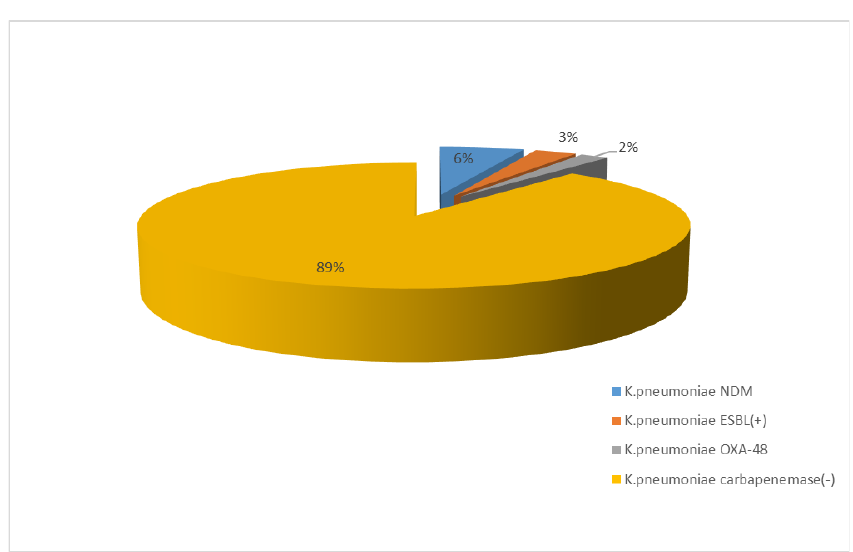
Figure 18. Comparison of the percentage of K. pneumoniae strains susceptible and resistant to carbapenems in 2021.